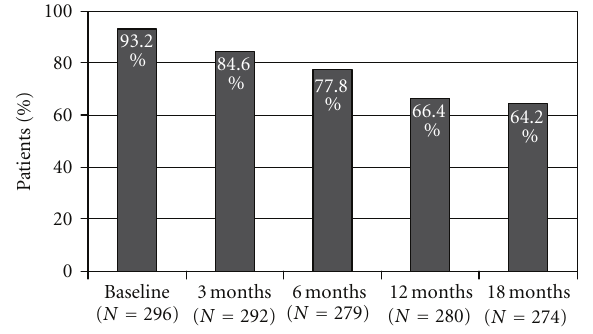
Figure 1: Back pain